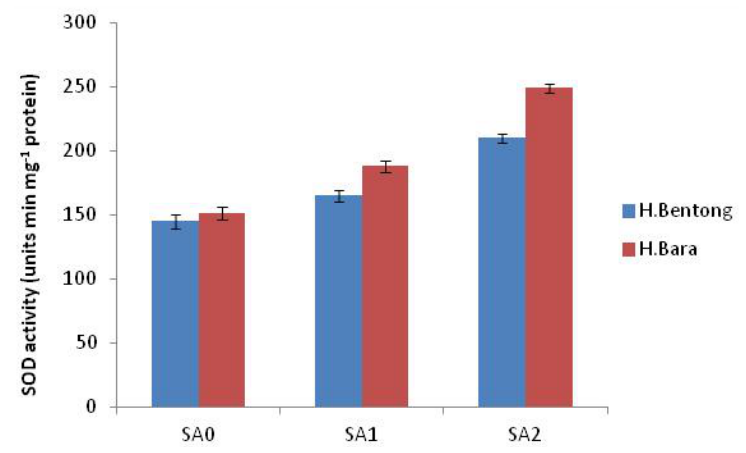
Figure 5. Superoxide dismutase (SOD) activity in Halia Bentong and Halia Bara treated with different concentrations of SA (SA0: control; SA1: 10 –3 M; SA2: 10 –5 M).